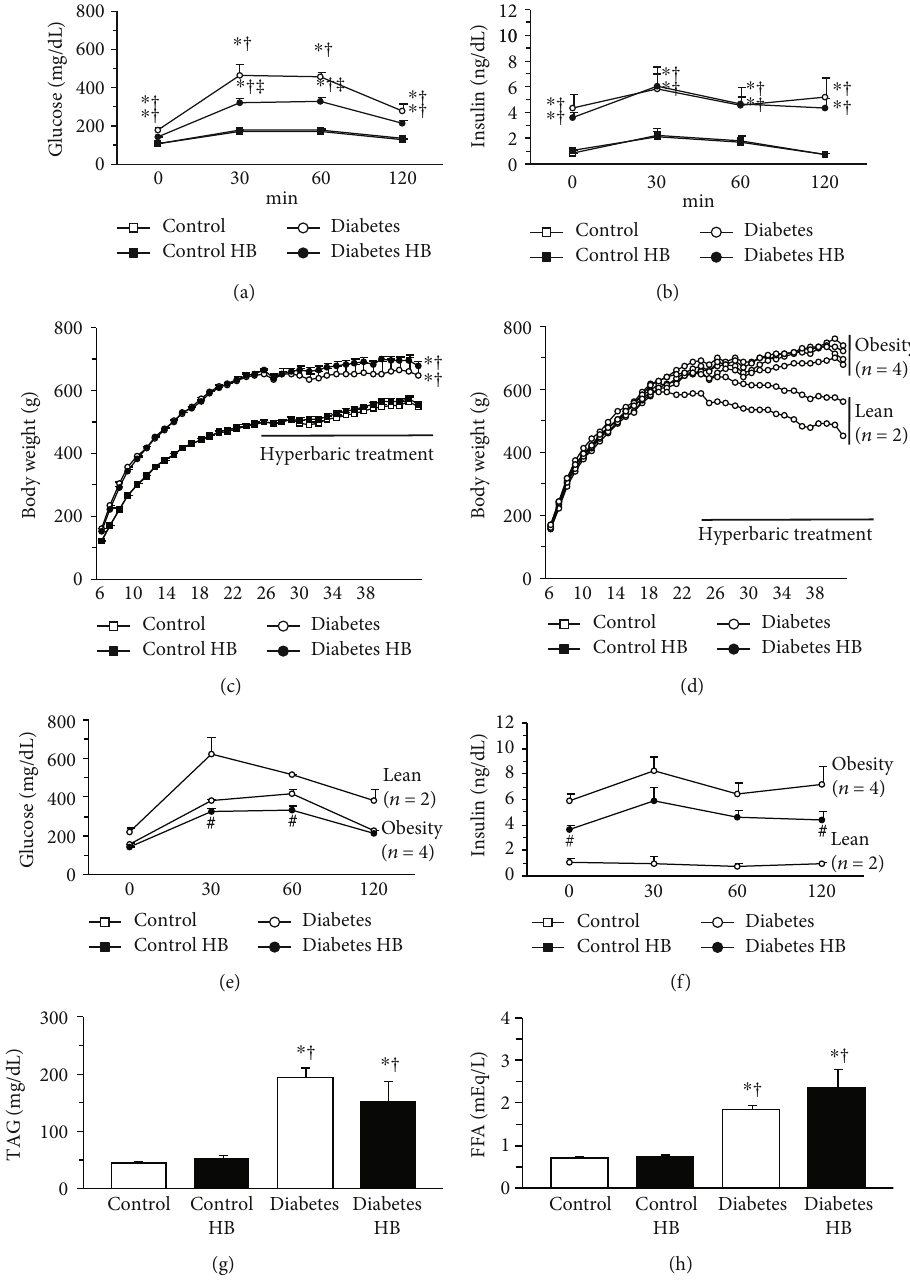
Figure 1: Glucose tolerance, insulin sensitivity, and metabolic properties. Glucose levels (a) and insulin levels (b) during OGTT, time course of body weight changes (c), values for the diabetes group (d – f), fasting plasma TAG levels (g), and FFA levels (h). Control: nontreated control group; Control HB: control treated with the hyperbaric normoxia group; Diabetes: nontreated diabetes group; Diabetes HB: diabetes treated with the hyperbaric normoxia group. The Diabetes group was further divided into the Diabetes obesity and Diabetes lean subgroups. Time zero: fasting. Values are means ± standard deviation . ∗ , † , ‡ Signi fi cantly di ff erent from the Control, Control HB, and Diabetes groups, p < 0 : 05 , respectively. # Signi fi cantly di ff erent from the Diabetes obesity and Diabetes lean subgroups, p < 0 : 05